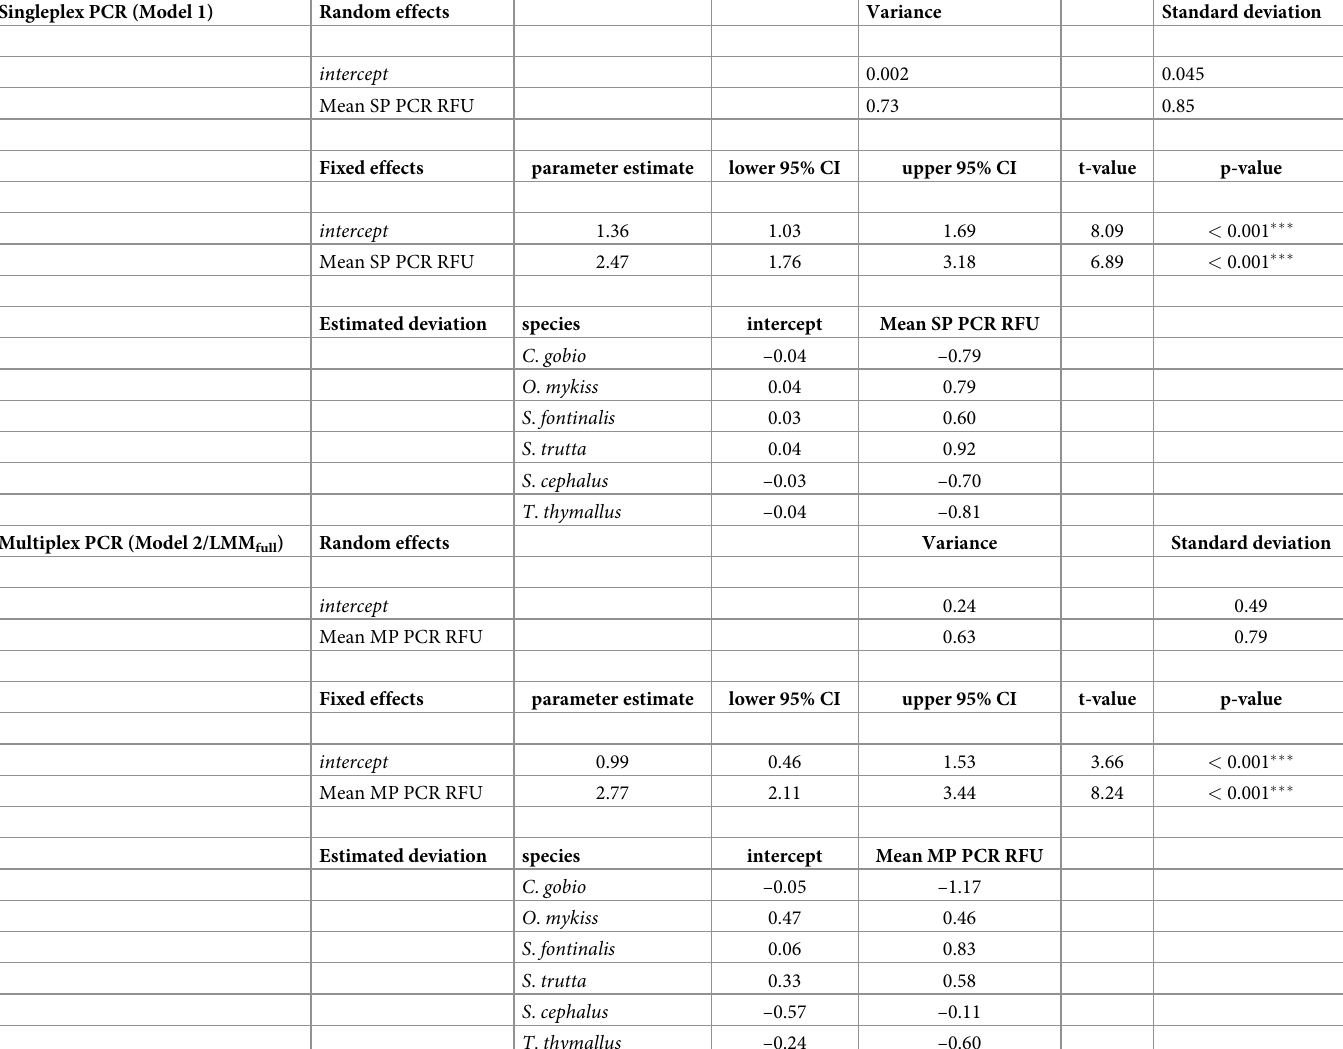
Table 3. Linear mixed-effects models for singleplex and multiplex celPCR. Singleplex PCR (Model